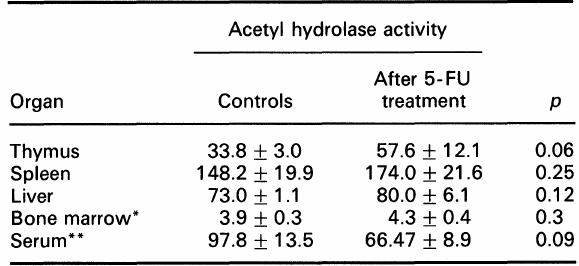
Table 1. Acetylhydrolase activity in spleen, thymus, liver, femoral bone marrow and serum on control and 5-FU treated